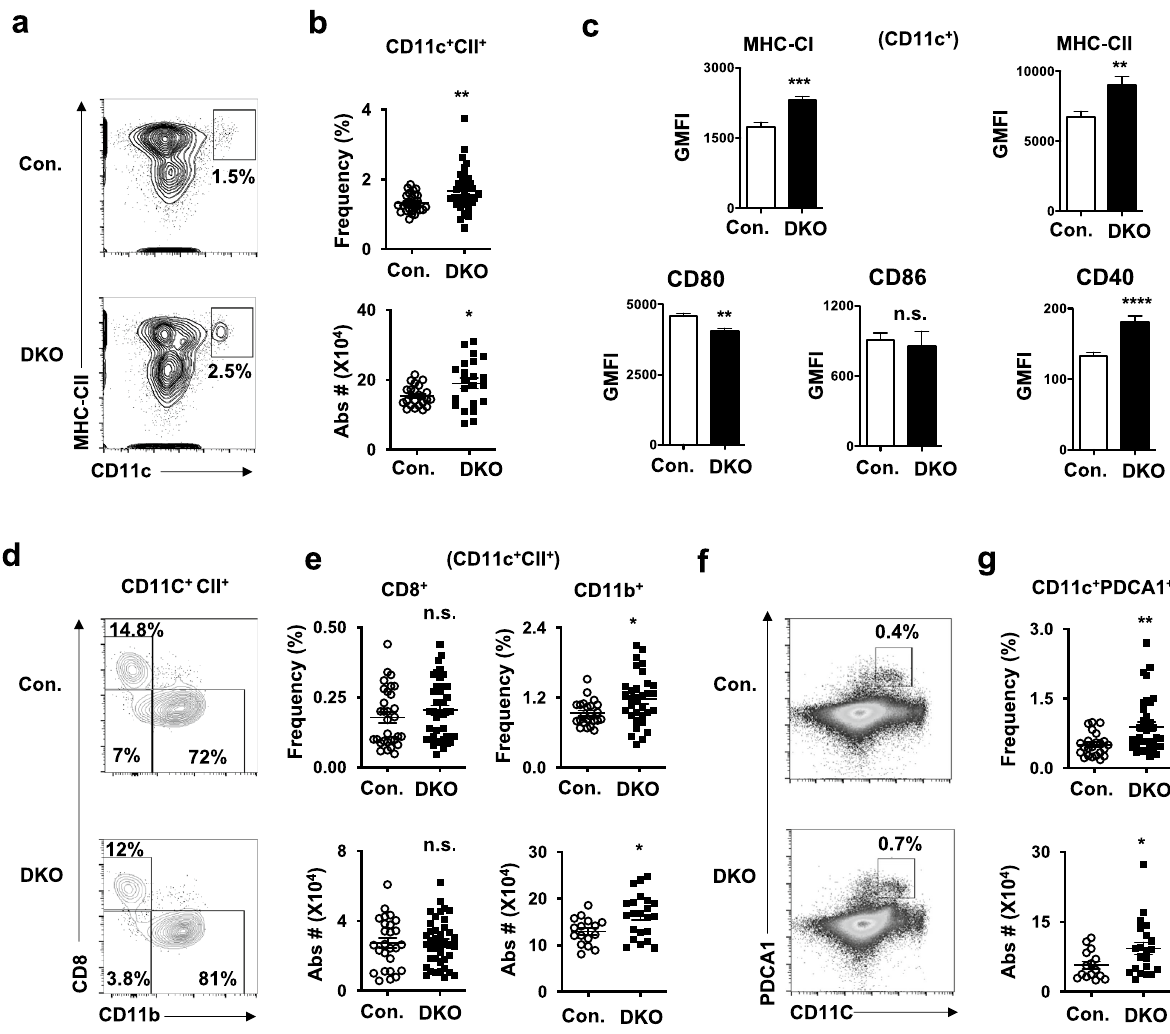
Figure 1. p85 deficiency leads to increased differentiation of DCs in the spleen. ( a ) FACS plots indicating frequencies of CD11c + CII + DCs in the spleen of p85α and p85β (DKO) and control mice. Shown are the frequencies within the indicated gates. Data are representative of 5 independent experiments. ( b ) Frequencies (top) (n = 28–38) and absolute numbers (bottom) (n = 22) of CD11c + CII + cells in the spleen of DKO and control mice. Indicated are the overall frequencies within spleen. ( c ) Surface expression levels of MHC-Class I, MHC- Class II, CD80, CD86 and CD40 in splenic CD11c + cells of and control mice (n = 11). Shown are Geomean fluorescence Intensities (GMFI) of surface markers in CD11c + gated cells. ( d ) FACS plots indicating frequencies of CD8 + (cDC1) and CD11b + (cDC2) subsets within pre-gated CD11c + CII + fraction in the spleen of p85α and p85β (DKO) and control mice. Shown are the frequencies within the indicated gates. Data are representative of 5 independent experiments. ( e ) Frequencies (top) (n = 31–40) and absolute numbers (bottom) (n = 16–40) of cDC1 (left) and cDC2 (right) subsets in the spleen of DKO and control mice. Indicated are the overall frequencies within spleen. ( f ) FACS plots indicating frequencies of CD11c + PDCA1 + (pDC) fraction in spleen of DKO and control mice. Data are representative of 5 independent experiments. Shown are the frequencies within the indicated gates. ( g ) Frequencies (top) (n = 23–36) and absolute numbers (bottom) (n = 15–21) of pDC subsets in the spleen of DKO and Control mice. Indicated are the overall frequencies within spleen. Data represent mean and s.e.m. Two-tailed student’s t tests were used to assess statistical significance (* P < 0.05, ** P < 0.01, *** < 0.001, **** < 0.0001, n.s. P >